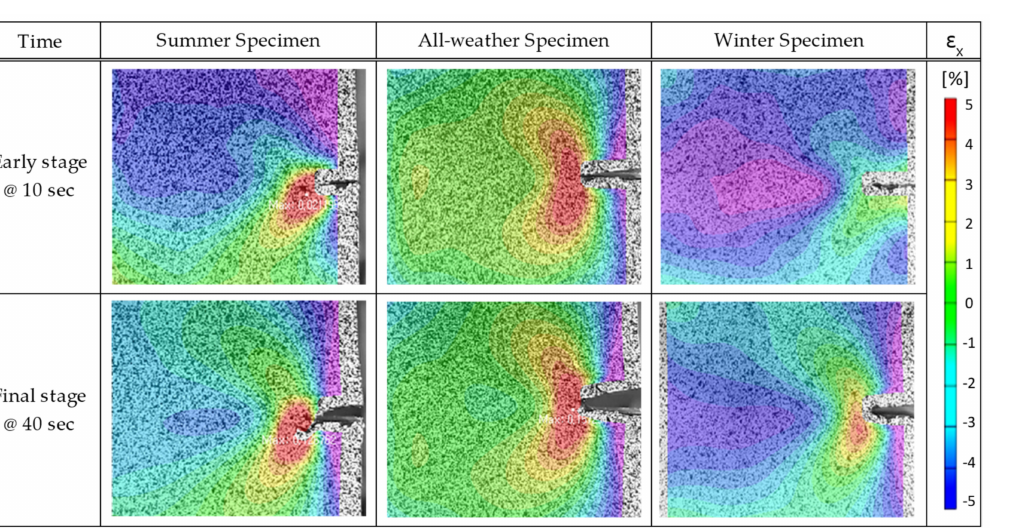
Figure 11. Major strain contours at 5